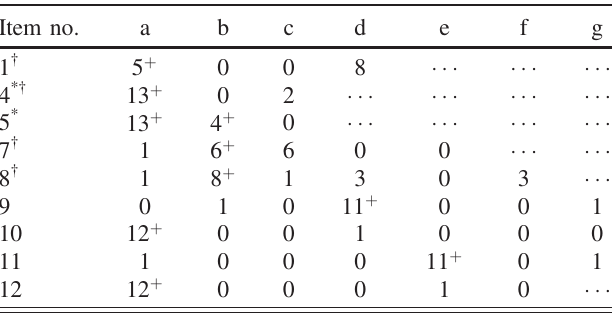
TABLE VII. The number of choices of a specific option during the interviews. There was a total number of thirteen